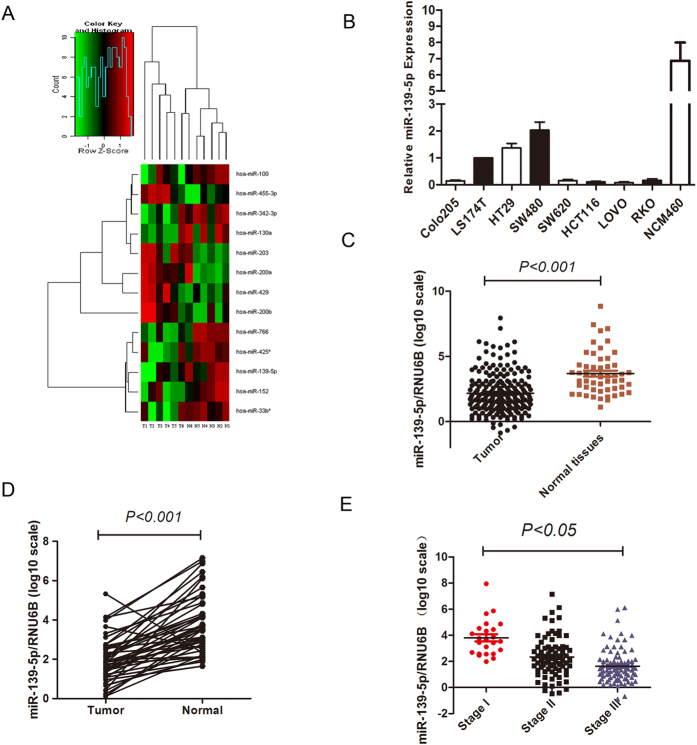
miR-139-5p was downregulated in colorectal cancer.(A) Heat map. miRNA microarray analyses were performed in six paired tumour and normal tissues. The green in the legend represents downregulation, and the red represents upregulation. (B) Determination of miR-139-5p expression levels in eight colon cell lines and NCM460 cells (mean ± SEM). (C,D) Downregulation of miR-139-5p expression in primary colorectal cancer tissue compared their normal tissue (paired Student’s t-test). (E) miR-139-5p expression levels decreased significantly with the advance of the tumour stage.